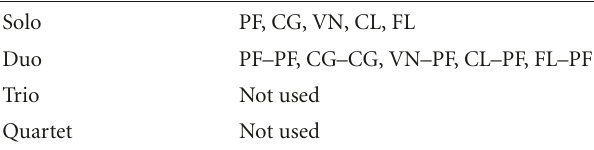
Table 9: Instrument combinations in Experiment